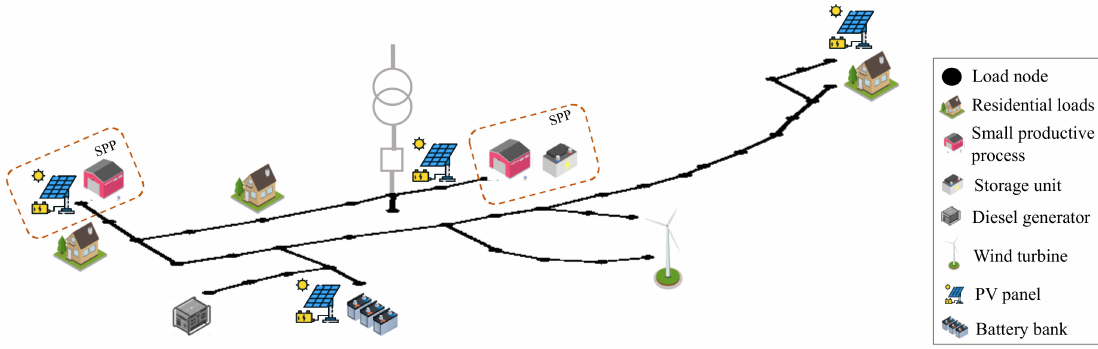
Figure 1. Microgrid including some cases of